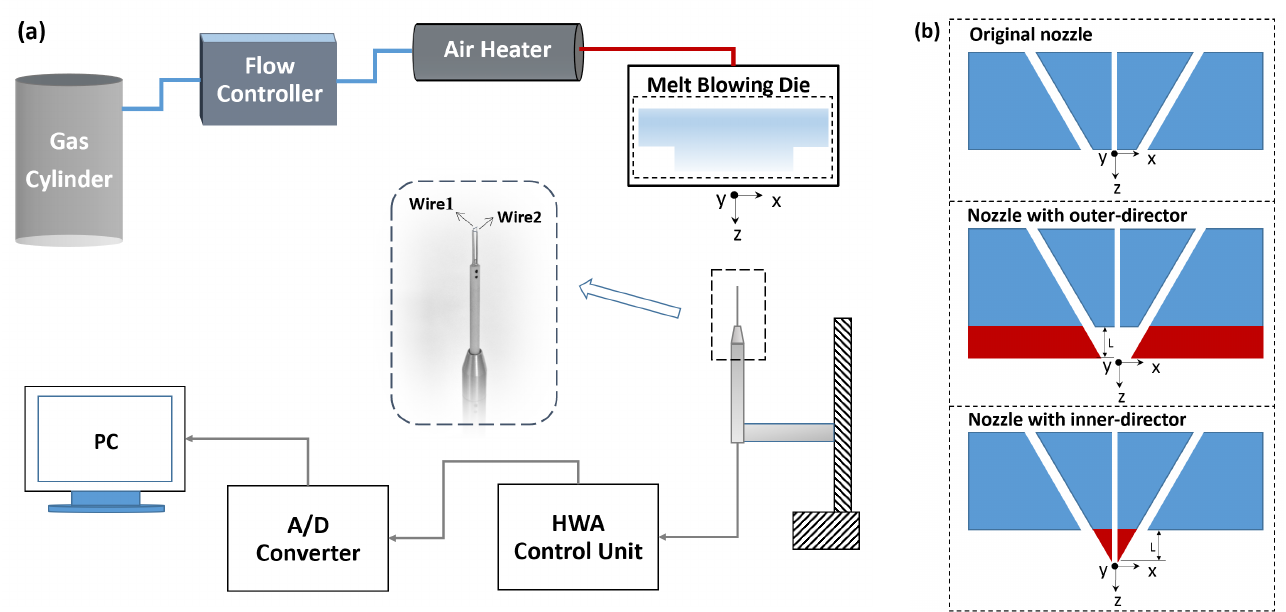
Figure 1. ( a ) Schematic of melt-blowing device and hot-wire measuring system. ( b ) Schematic nozzle configurations (cross-sectional